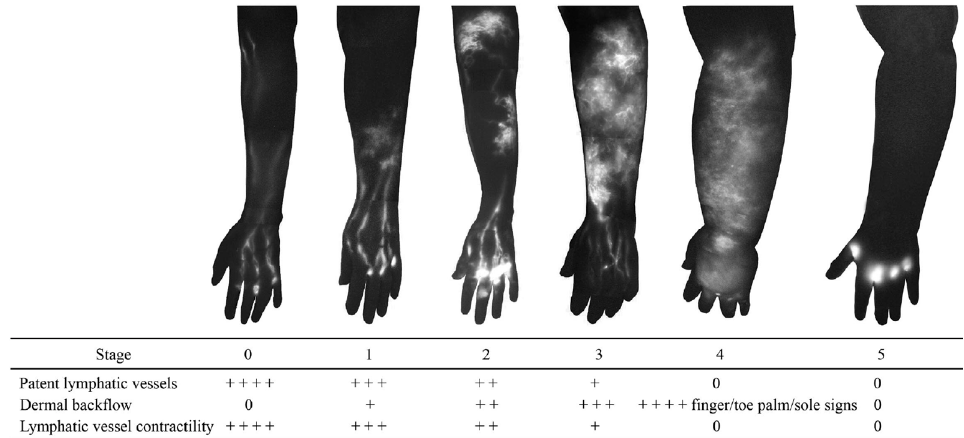
Figure 4. Indocyanine green lymphography staging scale. Stage 0 represents normal lymphatics, and stages 1 to 5 represent increasing lymphoedema severity. There is no dye movement at Stage 5. (Reproduced from [35] with permission).